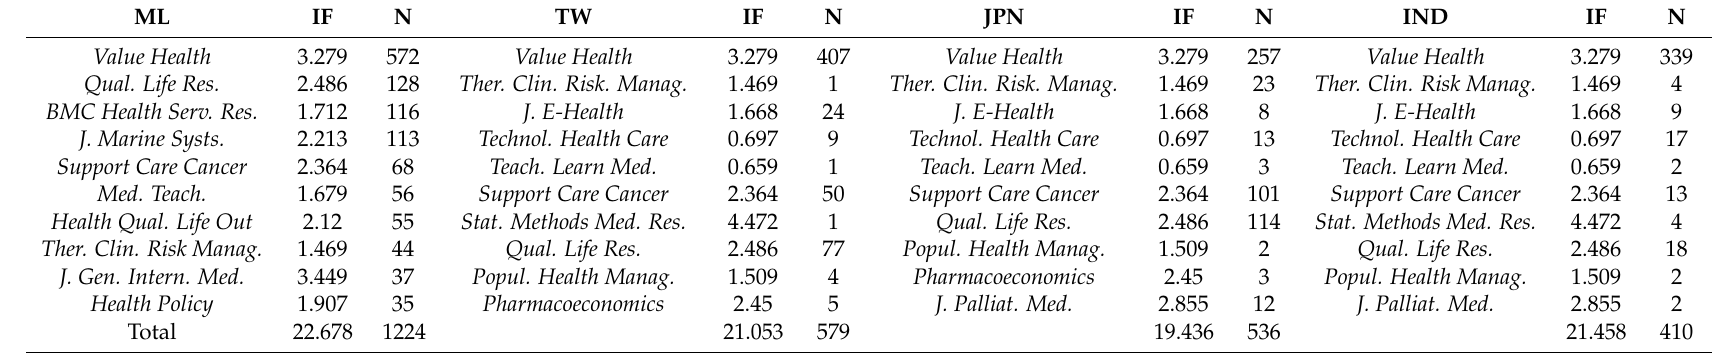
Table 4. Top 10 journals publishing the most articles written by researchers from Mainland China (ML), Japan (JPN), Taiwan (TW), and India (IND). ML IF N TW IF N N Value Health Qual. Life Res. BMC Health Serv. Res. J. Marine